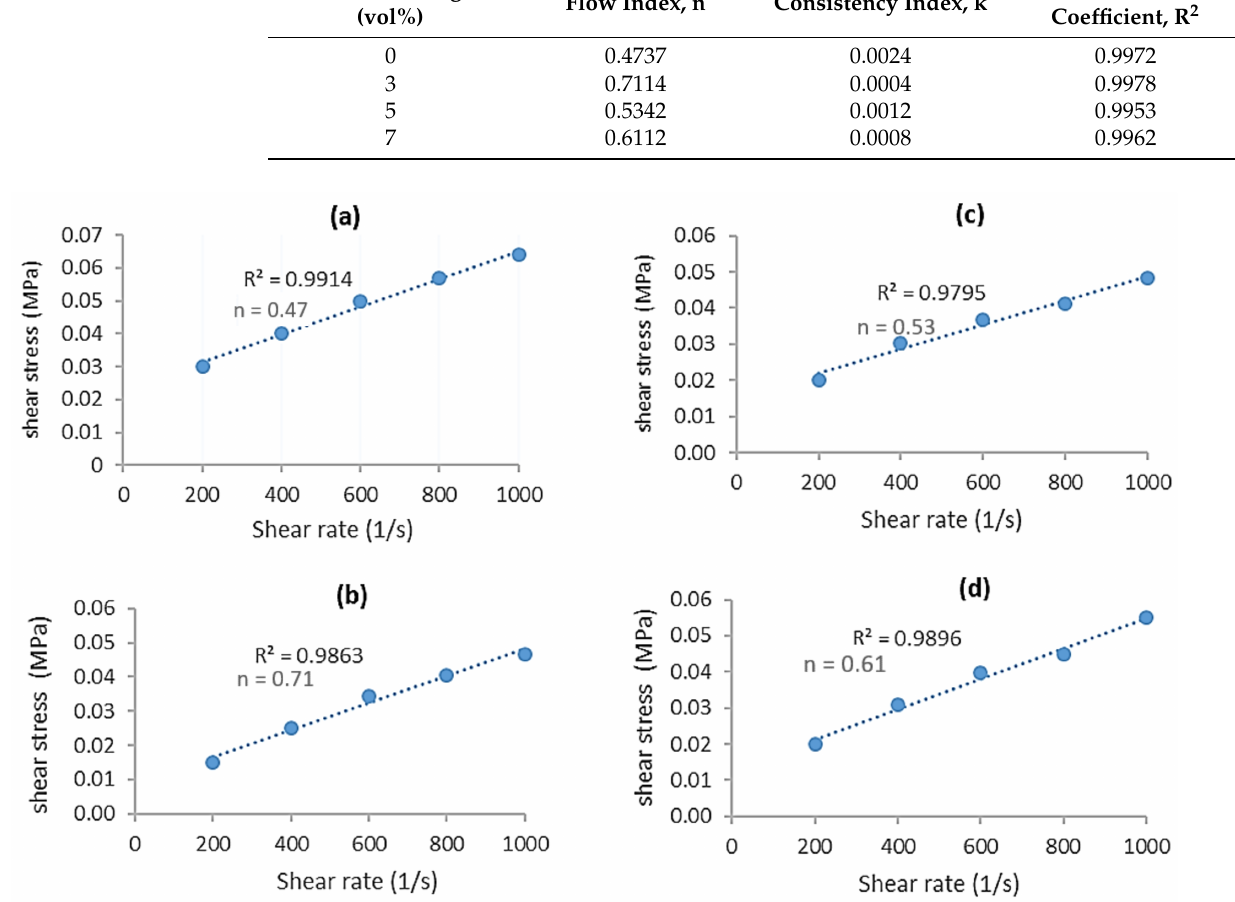
Figure 7. Flow curve graph for the ( a ) 0 wt%, ( b ) 3 wt%, ( c ) 5 wt%, and ( d ) 7 wt% of oil palm fiber composite